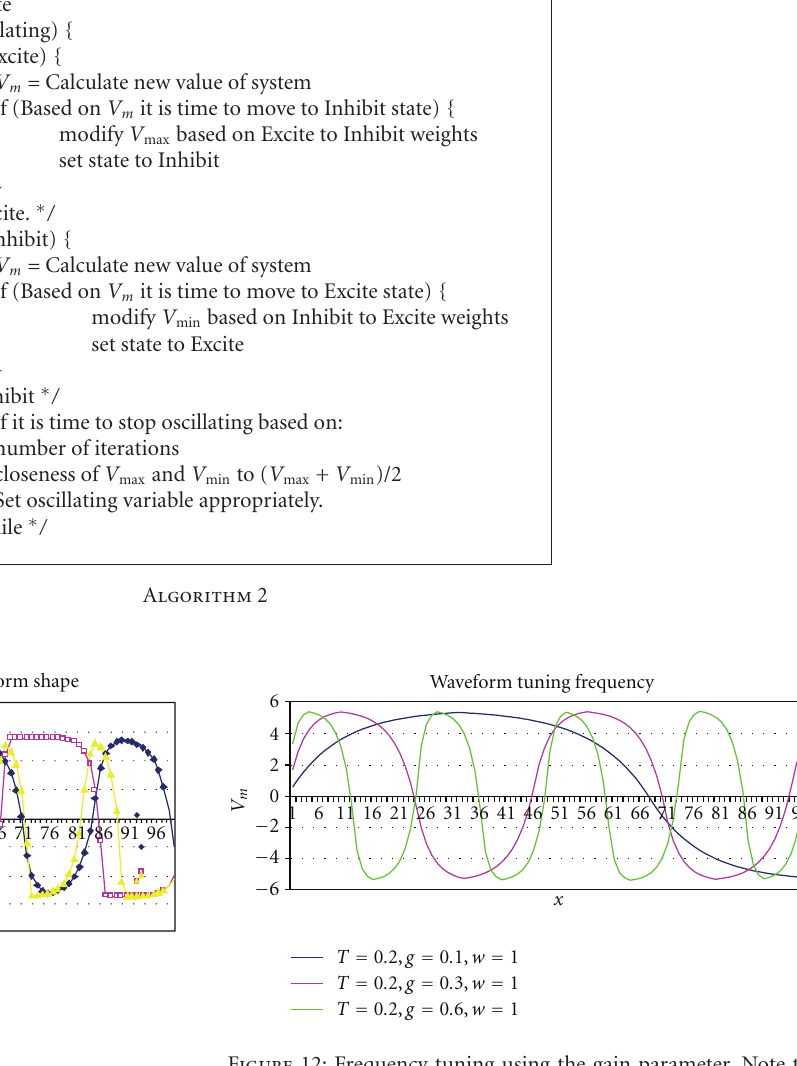
Figure 11: Various types of waveforms generated the symmetric 4 state oscillator. The di ff erent shapes are arrived at by manipulating the tolerance ( T ) and the gain ( g ). Of special note is the “saw-tooth like” waveform shown in yellow. It is the only one in which the gain for the rising side and falling side of the waveform are not equal.